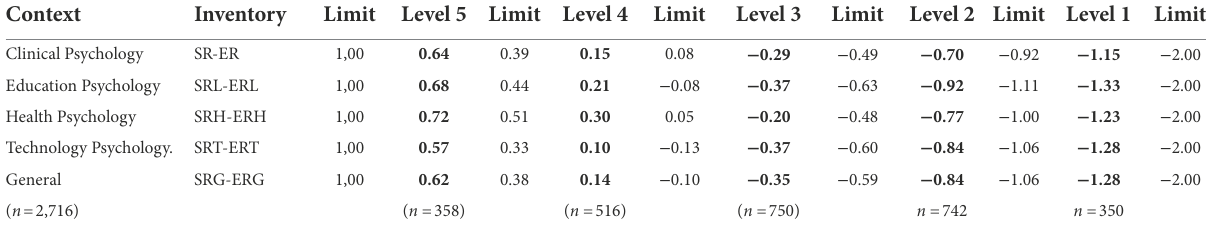
TABLE 3 Central and limit value for the clusters for each questionnaire and general.